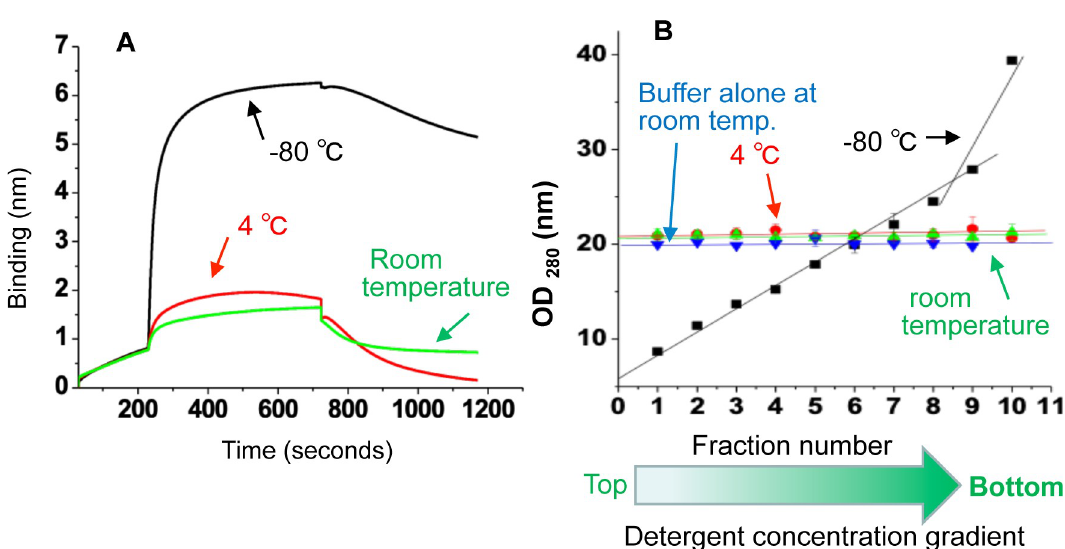
Fig 6. ( A ) The eluted fractions of the wild type N protein were 50% diluted and either frozen over night at– 80˚C or left at room temperature or at 4 oC. Next morning that thawed solution were poured into 1 ml fractions from top of the gradient. Shown are the BLI sensograms of N protein from the fraction 1, demonstrating the association and dissociation kinetics with the RNA. ( B ). The OD measurements of each fraction at 280 nm was carried out as mentioned in Fig 3. The OD values corresponding to the fraction number were plotted and the data points were fit to a straight